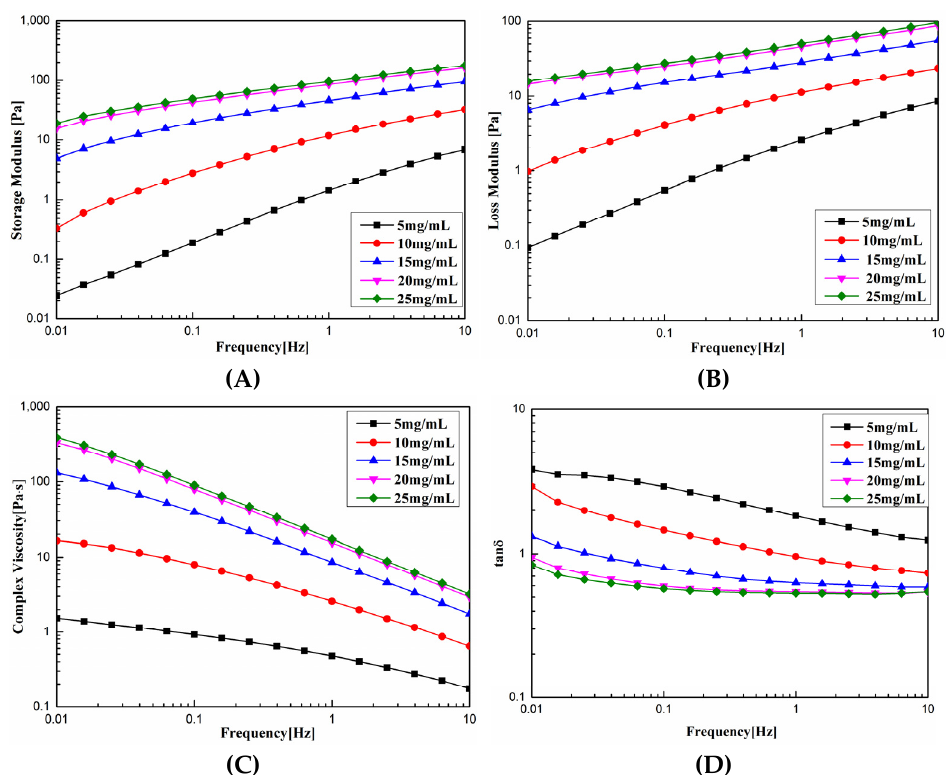
Figure 4. Dynamic rheological curve of SCSC at different concentrations. ( A ) Storage modulus (G ′ ); ( B ) loss modulus (G”); ( C ) complex viscosity ( η *); ( D ) tan δ .